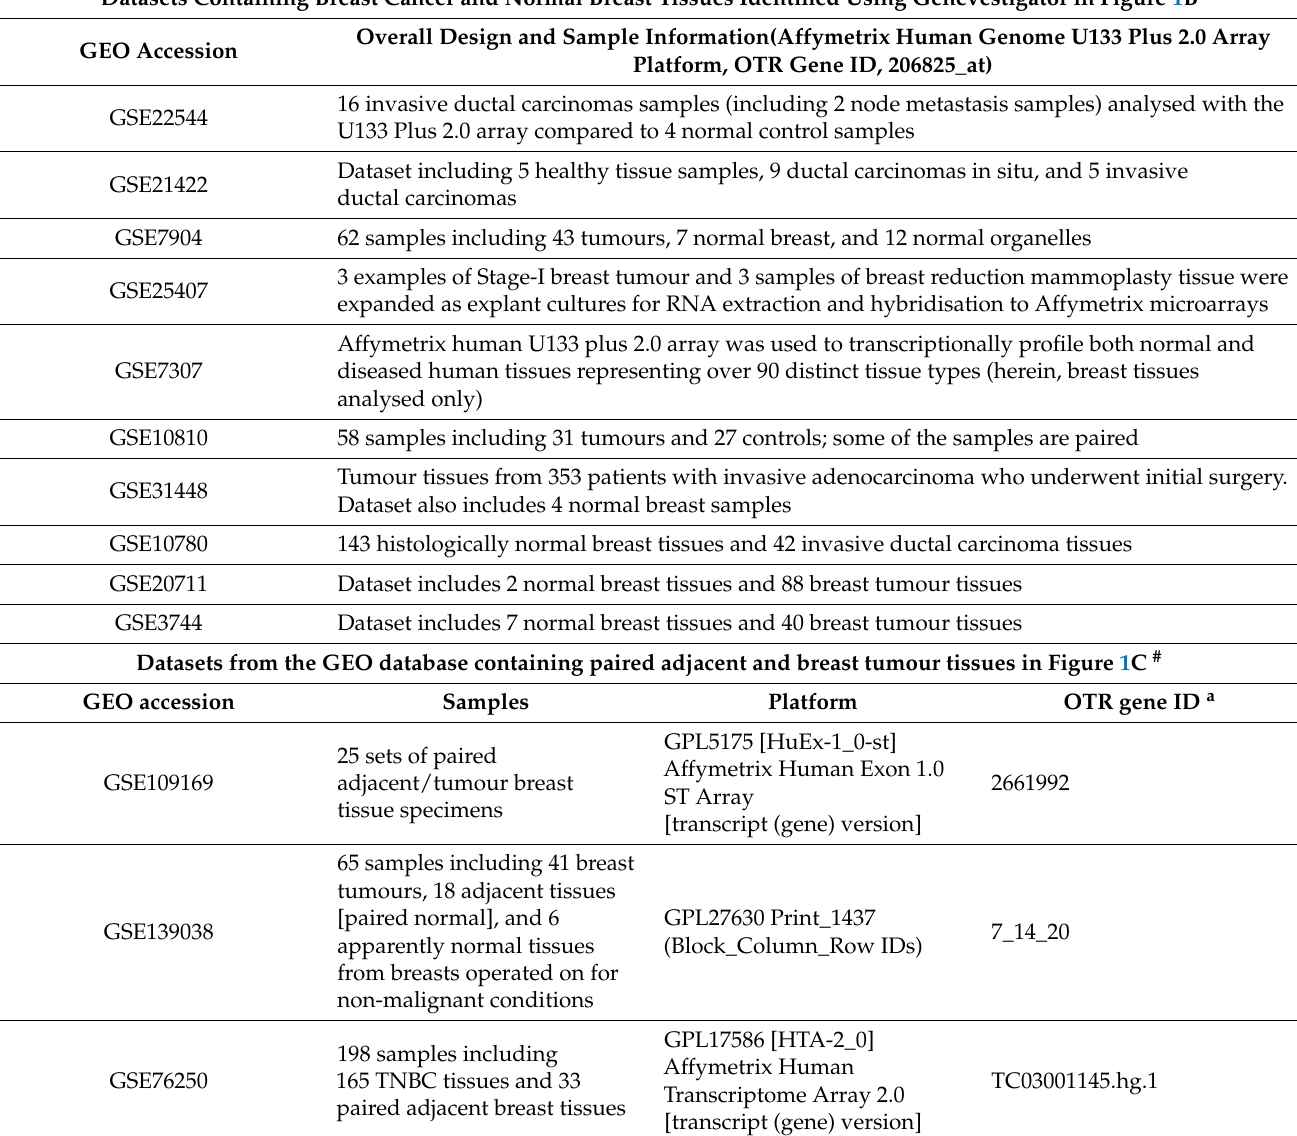
Table 1. Overview of the datasets containing both breast cancer and normal breast tissues identified in Genevestigator and in the GEO